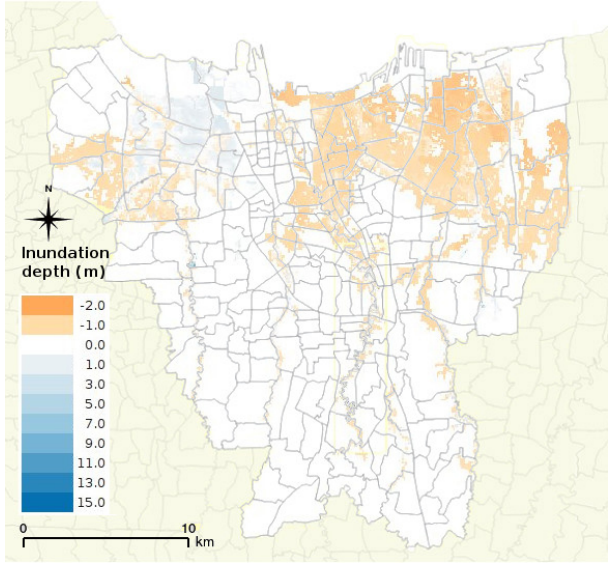
Figure 5. Change in inundation depth for a return period of 100 years in the flood hazard maps based on the SOBEK schemati- zation of 2013 compared to that of